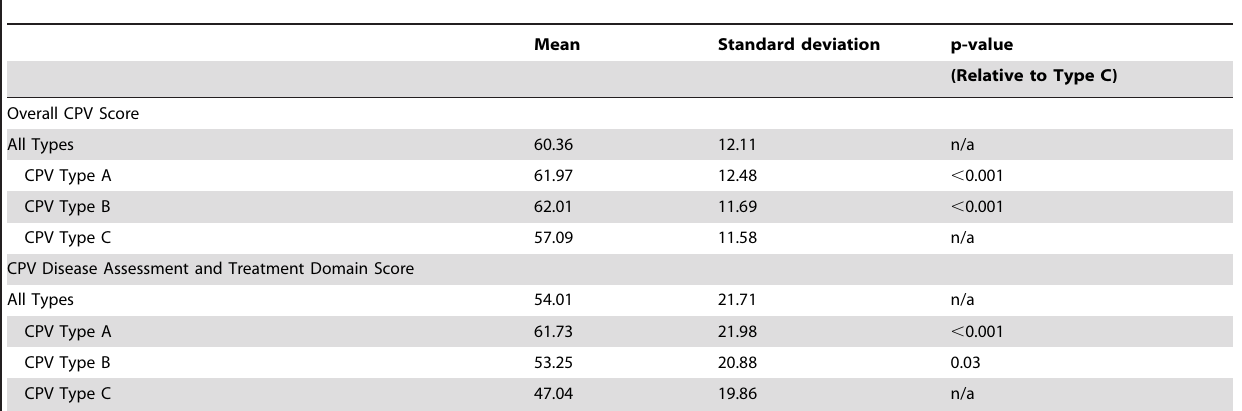
Table 2. Baseline Mean CPV Overall and Disease Assessment and Treatment Quality Scores for All Study